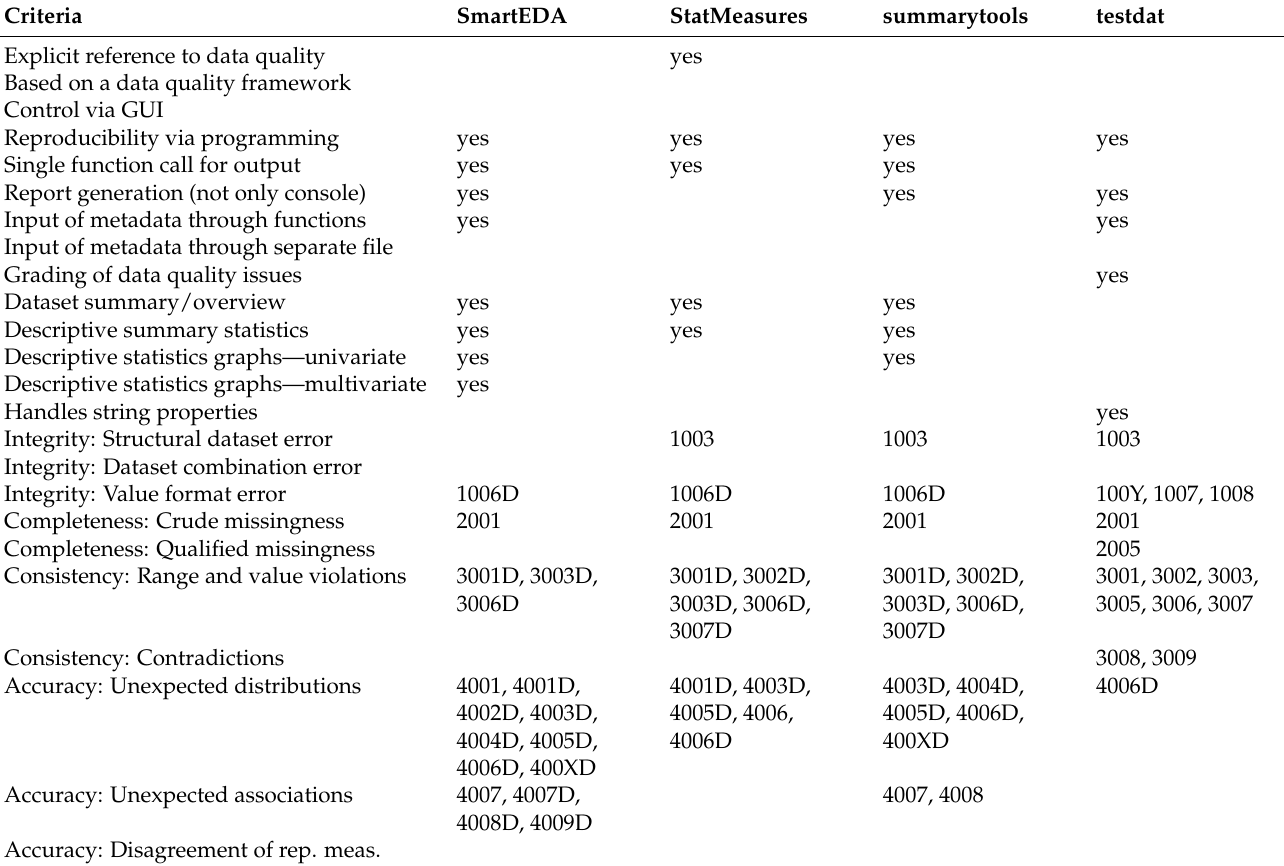
Table A6. Data quality assessment capabilities by package (continued).